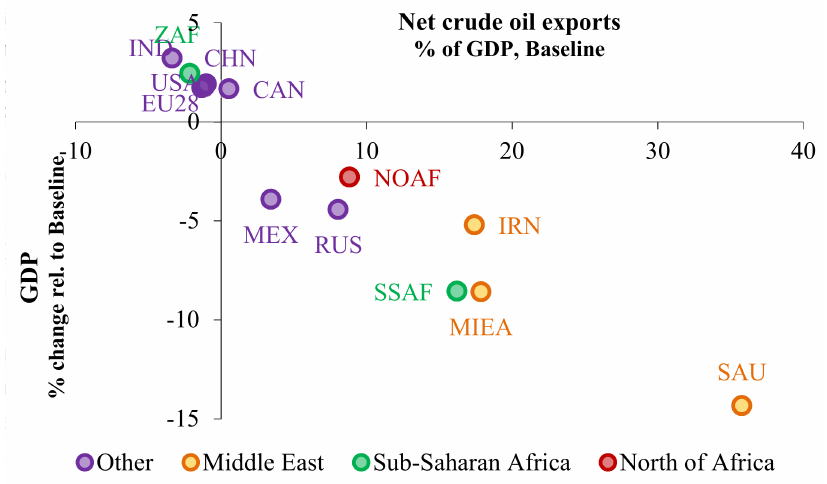
Figure 10. The impact of the low oil price on GDP vs. export dependence. Source: JRC-GEM-E3